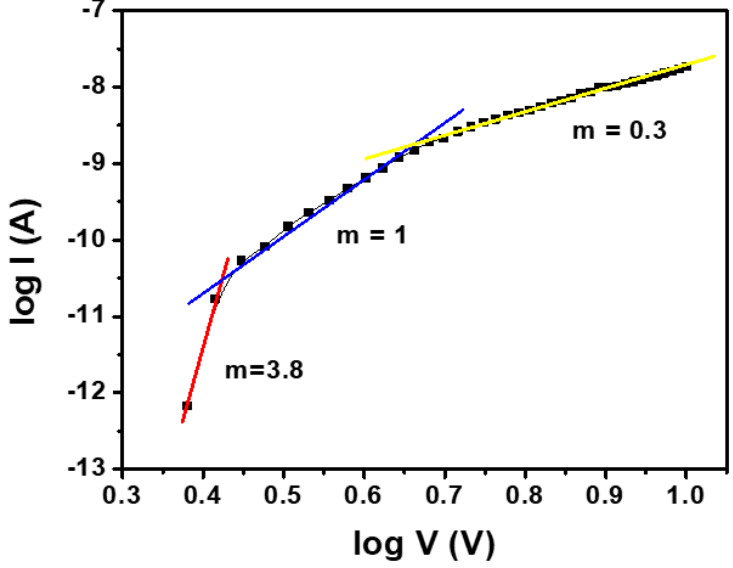
Figure 5. The forward log I vs. log V graph of the Ag/PFB/p-Si device.